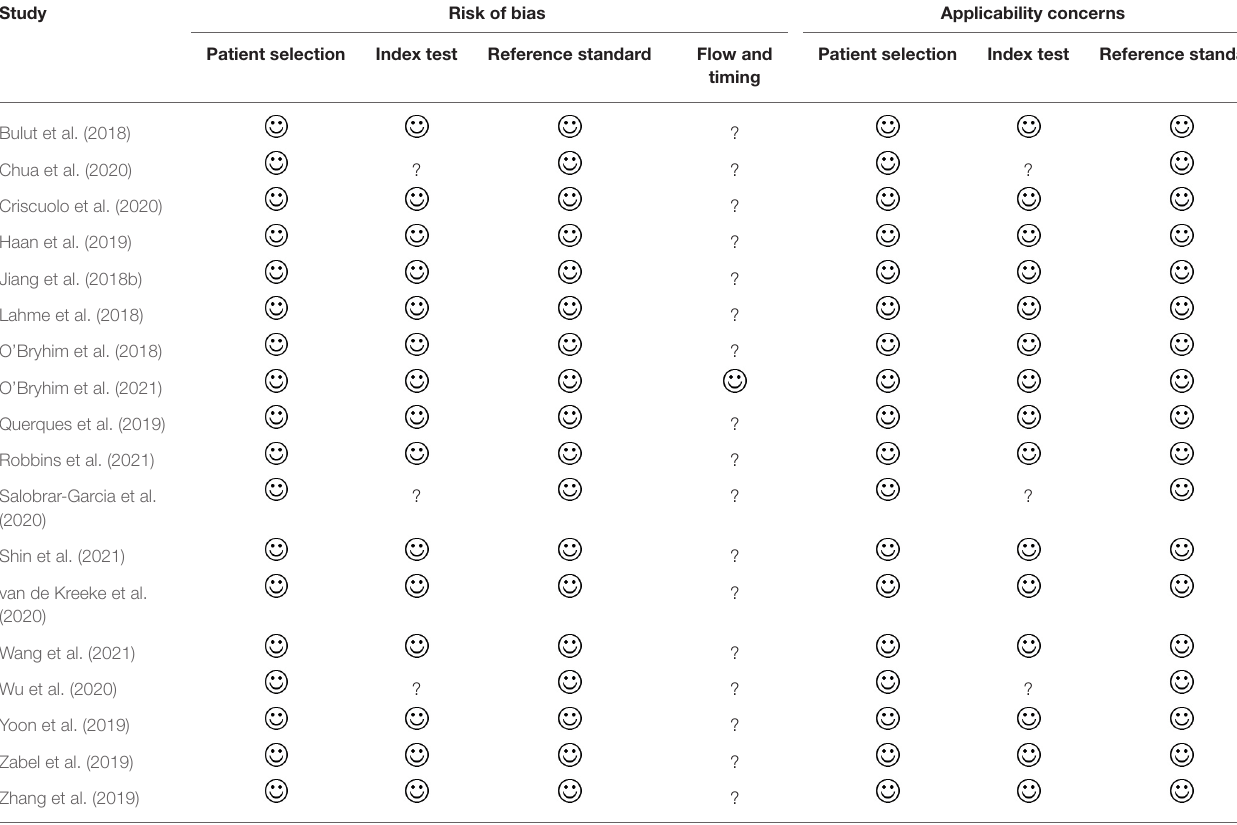
TABLE 5 | Risk of bias summary using the QUADAS-2